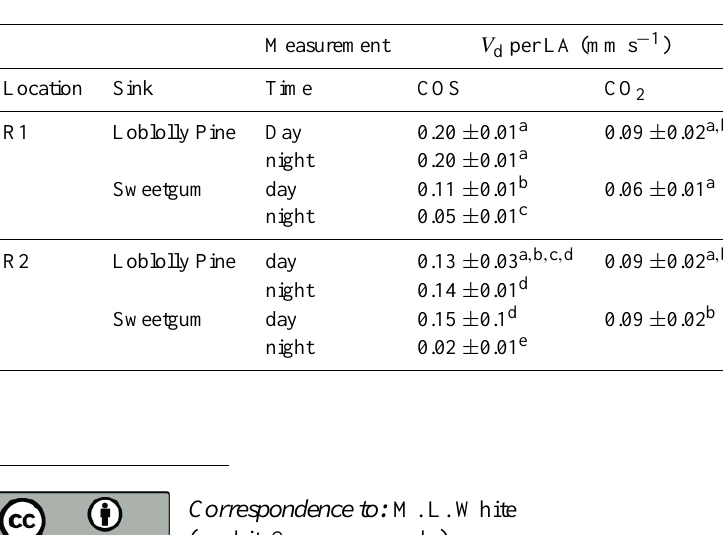
Table 1. Mean COS and CO 2 deposition velocities, V d , ± standard error ( n ≥ 10), for Ring 1 and Ring 2 vegetation. V d were calcu- lated from measured flux rates normalized to leaf area (LA) of the branch enclosed divided by PC COS and CO 2 mixing ratios at the time of flux. Superscripts a, b, c, d, and e indicate significantly different means within each column ( p < 0 . 05, independent means t-test, SPSS v.